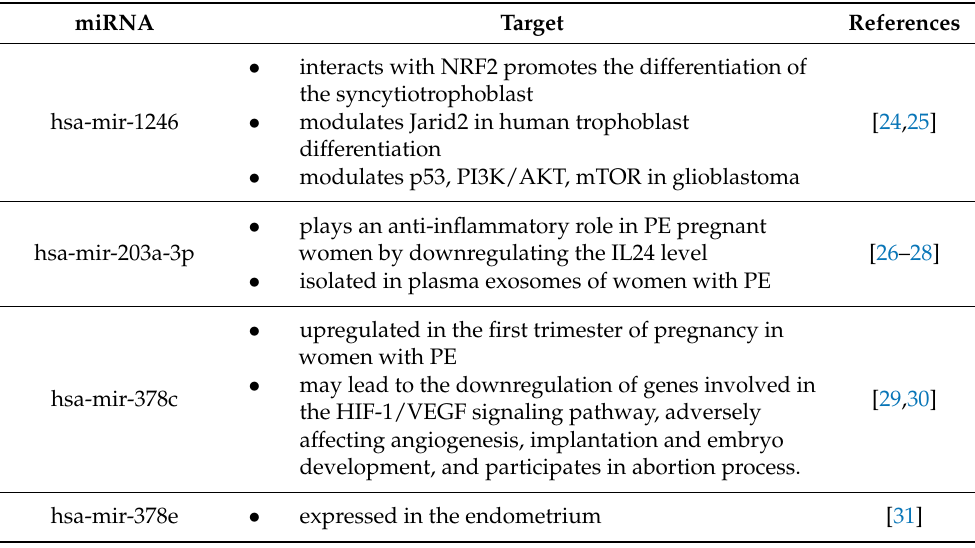
Table 1. Role and target of miRNAs in common between plasma and placenta in preeclampsia.